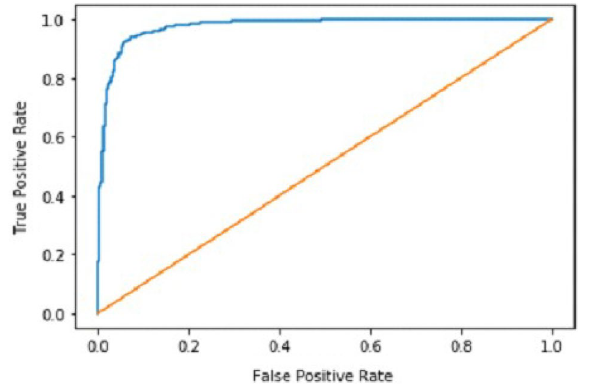
Figure 13. ROC curve of CNN1.